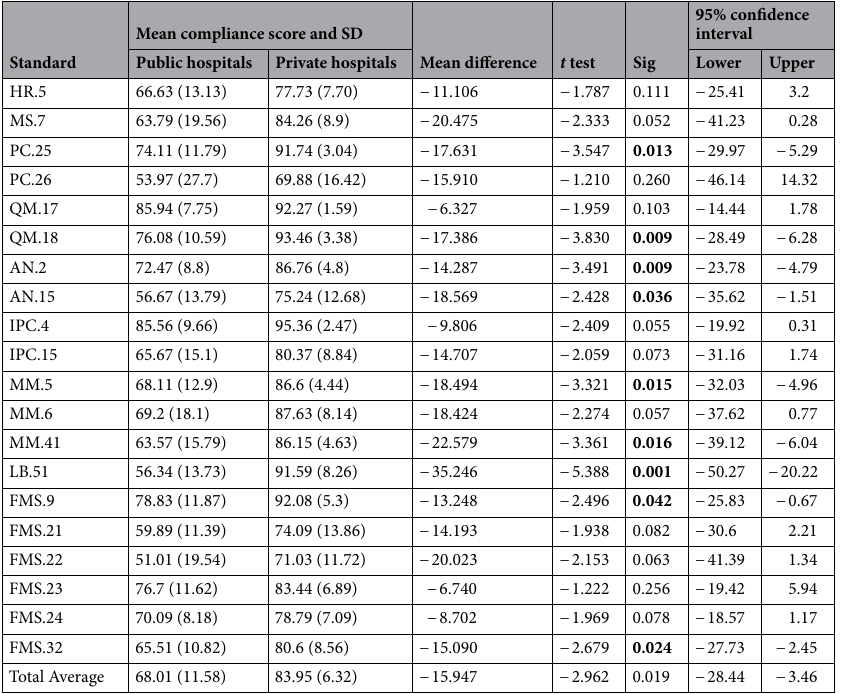
Table 3. Comparison of the mean compliance rate of ESR standards by hospital type (independent t test). Significant values are in